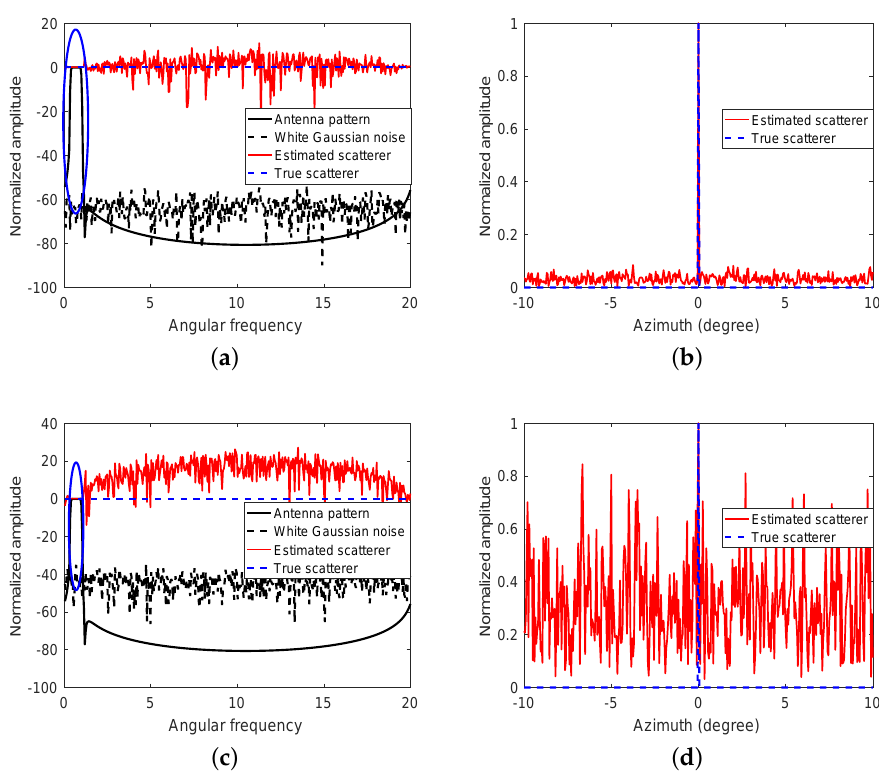
Figure 3. Singular value analysis. ( a , c ) are shown in the angular frequency domain; ( b , d ) are the comparison figures of estimated and true values; ( a ) SNR = 65 dB; ( b ) Least square solution of ( a ); ( c ) SNR = 45 dB; ( d ) Least square solution of ( c